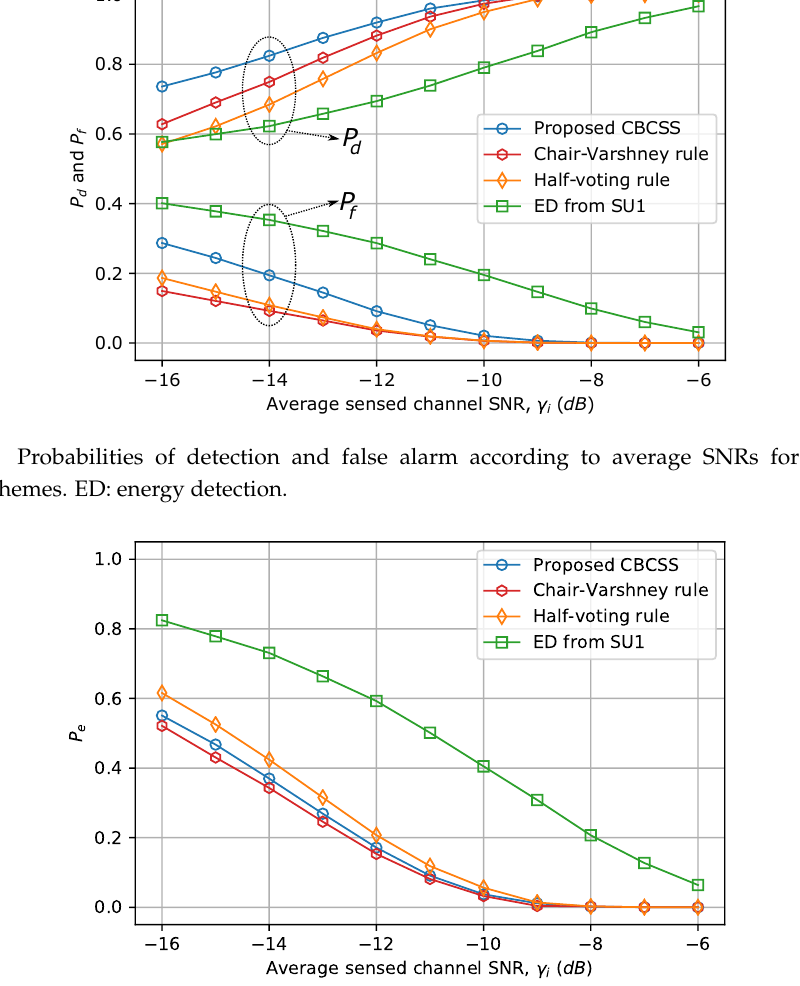
Figure 8. Sensing error according to average SNRs for different sensing